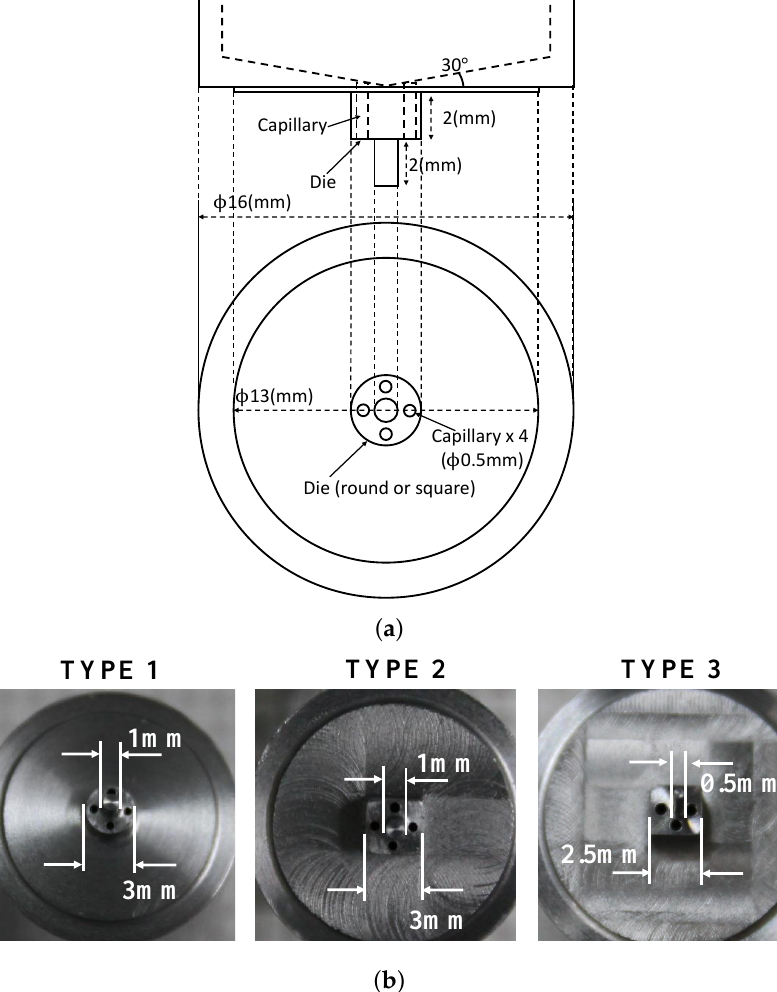
Figure 1. ( a ) Design drawing and ( b ) photographs of developed Mo